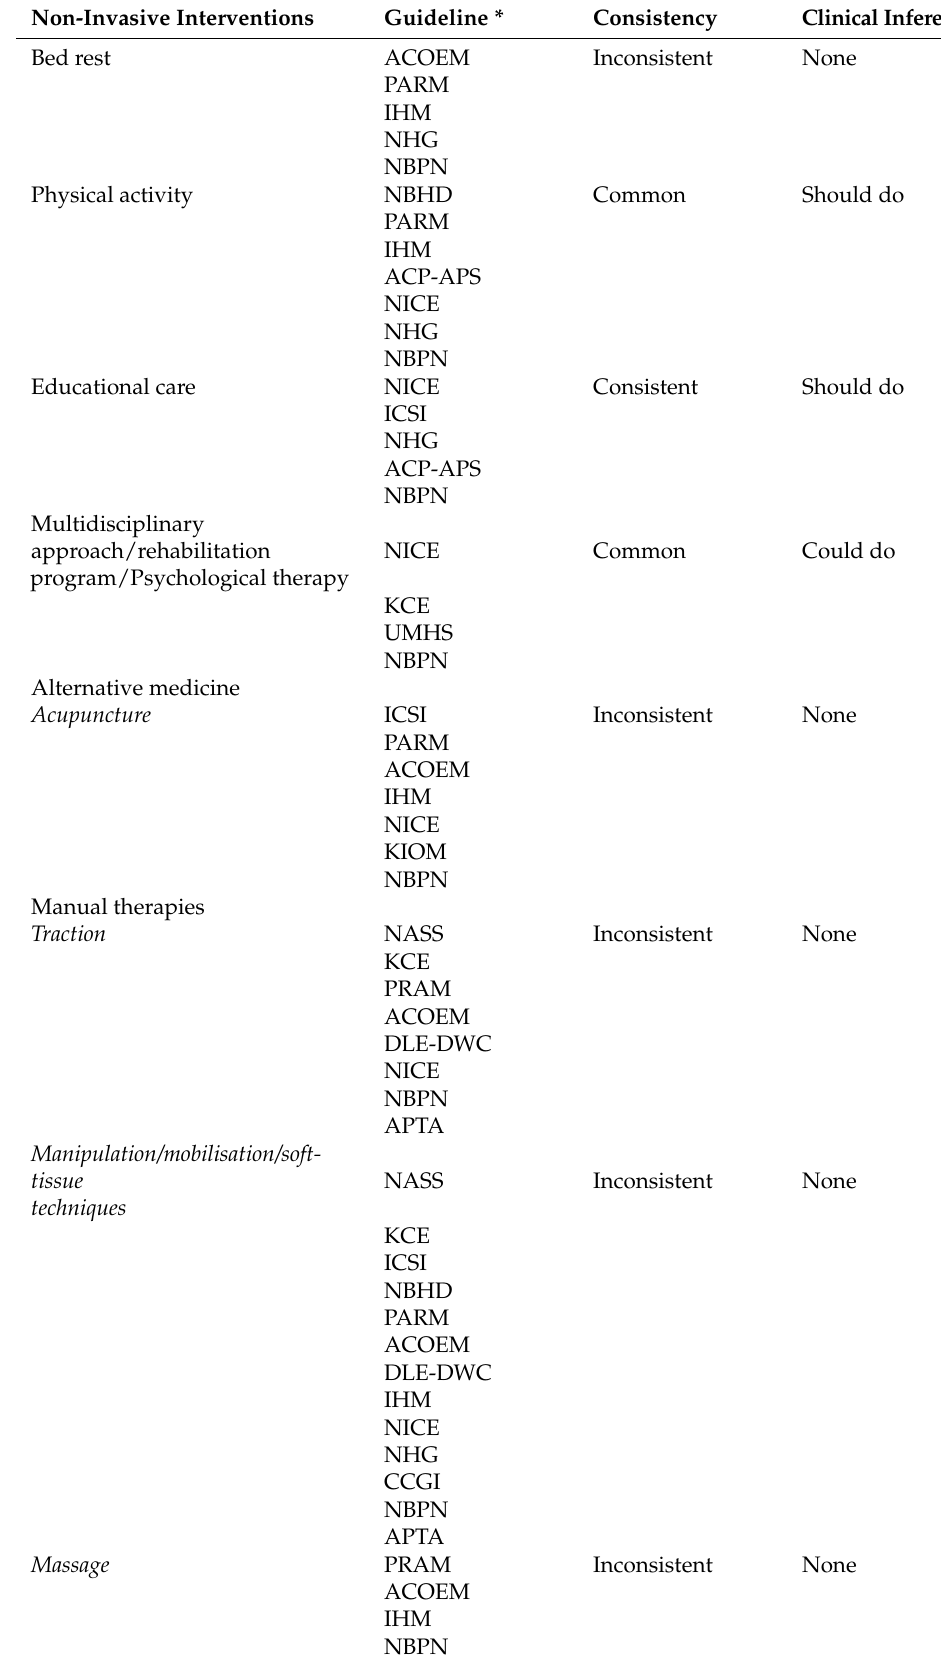
Table 5. Therapeutic recommendations from guidelines for lumbar radicular